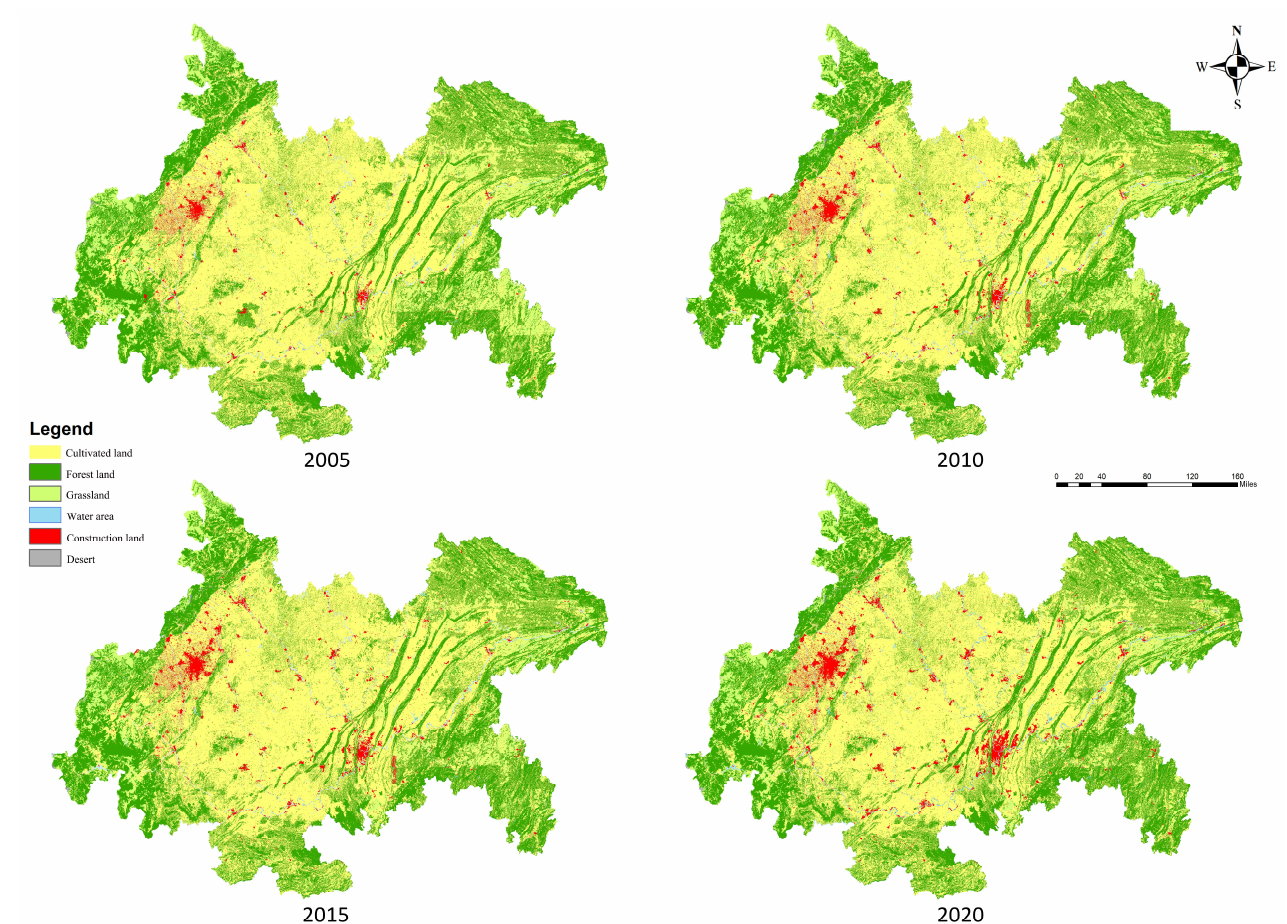
Figure 3. Ecosystem types of CCCG, 2005–2020.